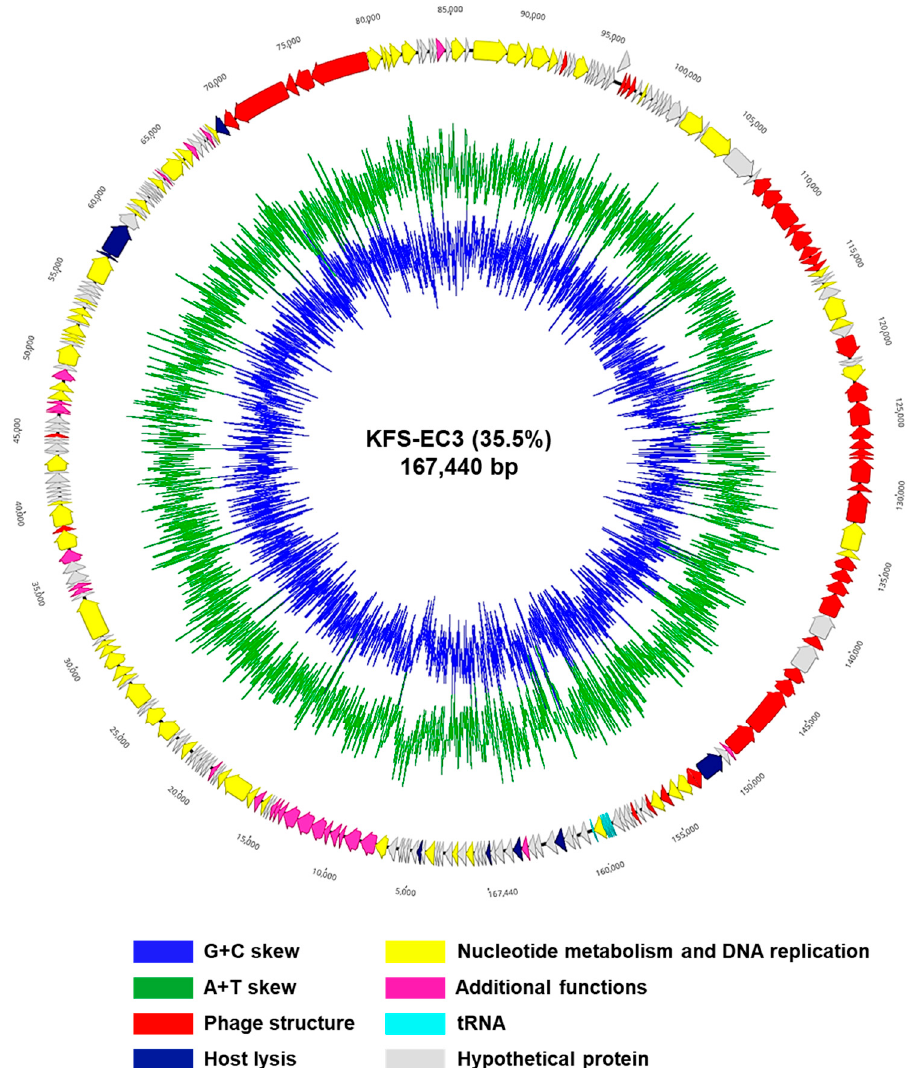
Figure 5. The genome map of KFS-EC3. The predicted ORFs (arrows) and direction of transcription (arrowheads) are indicated. The ORFs classified by the subsystem of the RAST pipeline were denoted as phage structure (red arrows), host lysis (navy), nucleotide metabolism and DNA replication (yellow), additional functions (pink), tRNA (sky blue), and hypothetical proteins (gray).